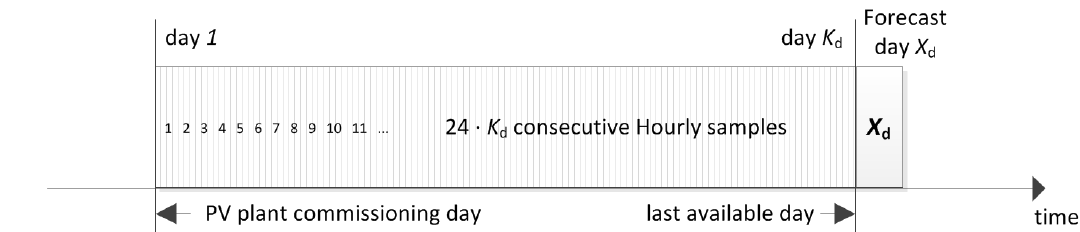
Figure 3. Hourly samples are progressively available in an incremental training database. PV: